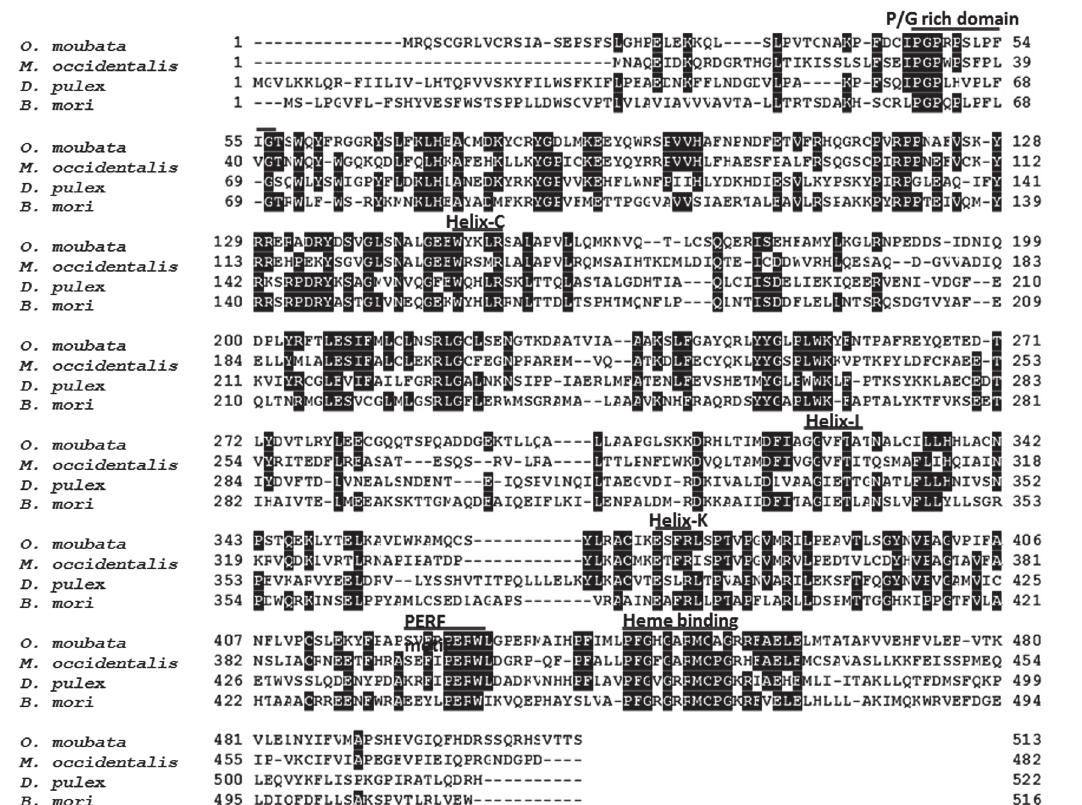
Fig 2. Multiple alignment of OmShd with orthologs determined for other arthropods. Location of a P/G rich domain, Helixes (Helix-C, Helix-I and Helix- K), a PEFR motif and a Heme binding domain are indicated.